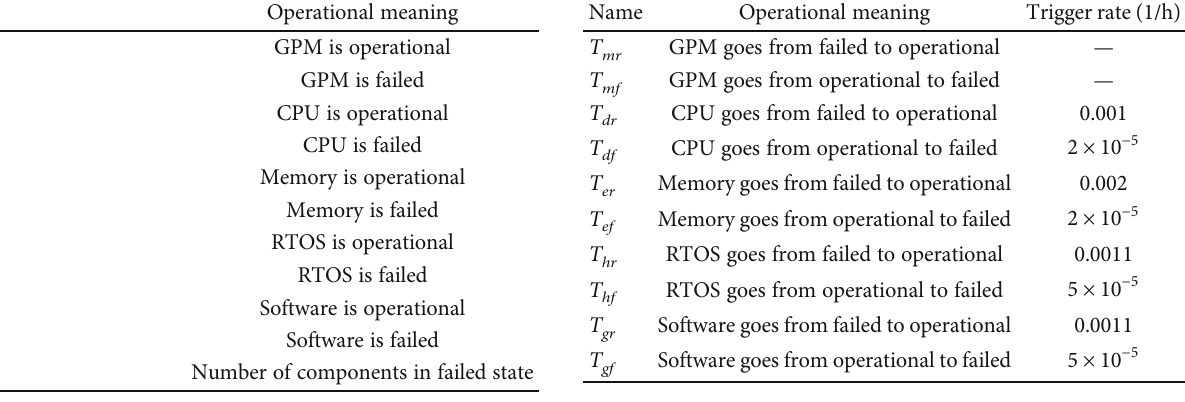
Table 1: Places in the GSPN model for GPM. Name